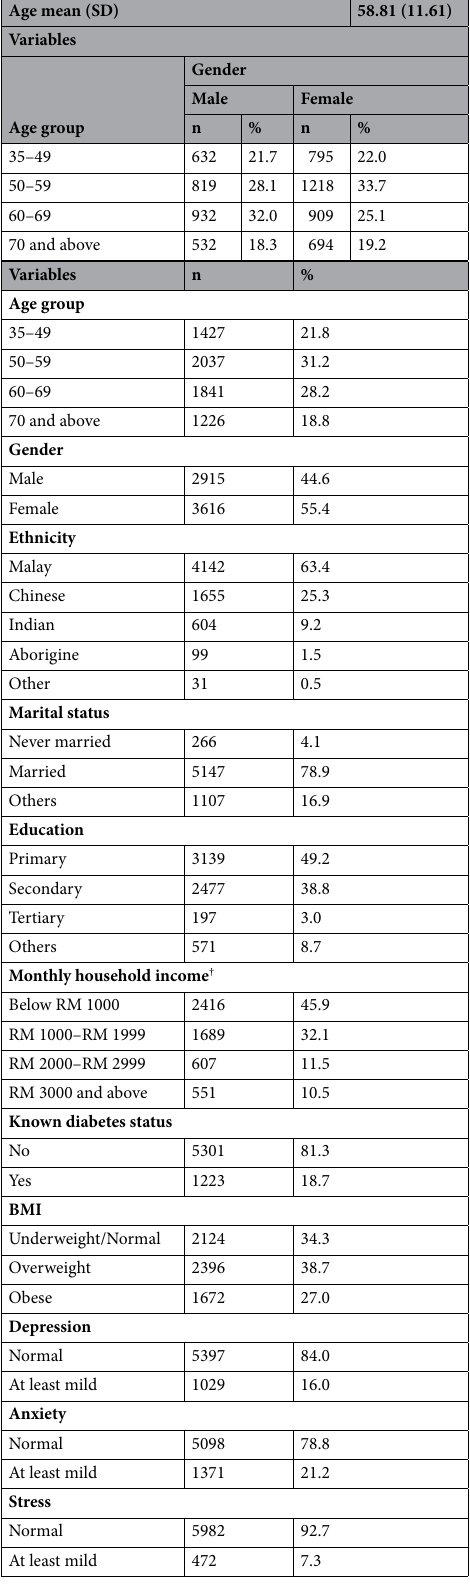
Table 1. Socio-demographics, health-related characteristics, and mental health status of respondents (N = 6531). BMI, Body Mass Index. Proportion are percentage of non-missing data. † USD1 is equivalent to